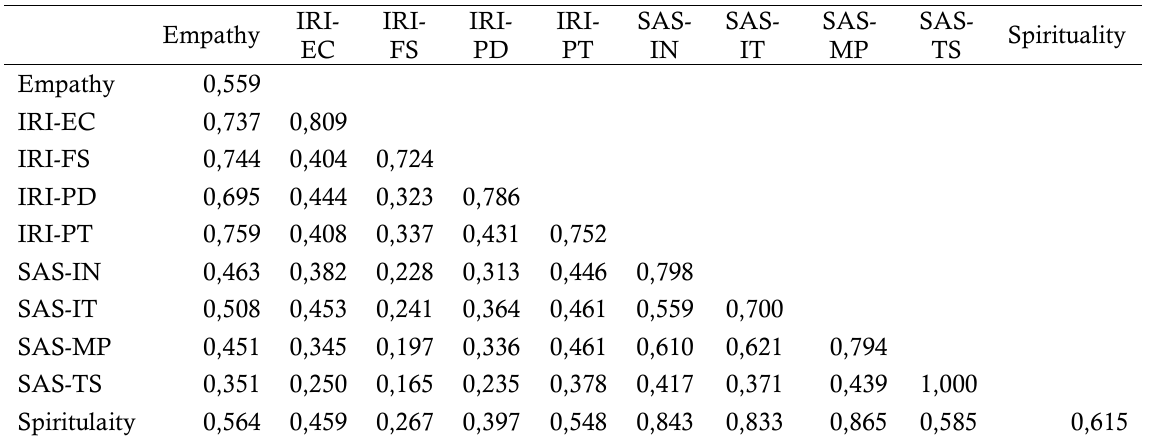
Table 2 . Discriminant